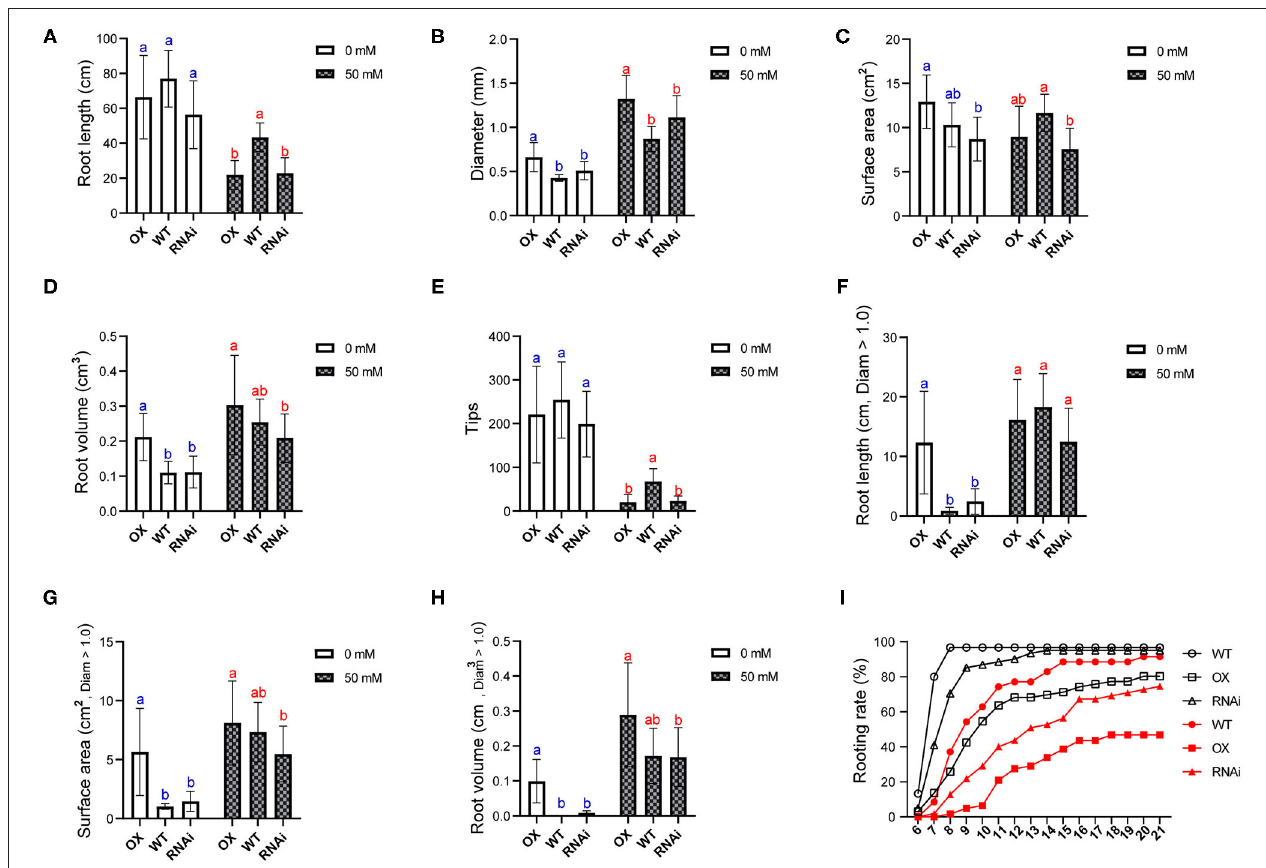
FIGURE 3 | PagERF16 promoted lateral root proliferation by increasing the diameter and volume. (A) Total length of root. (B) Average diameter of root. (C) Total surface area of root. (D) Total volume of root. (E) Tips of root system. (F–H) Represent the length, surface area, and volume of roots with diameter > 1.0mm, respectively. The plot represents the mean ± SD of six plants per line. Three OX or RNAi lines serve as three biological repeats. Different lowercases indicate significant differences among genotypes under the control (blue) or salt stress (red) conditions ( p ≤ 0.05). (I) Rooting rate of 60 shoots per genotype (OX, RNAi, and WT) sub-cultured on medium without (black) or with 50mM NaCl